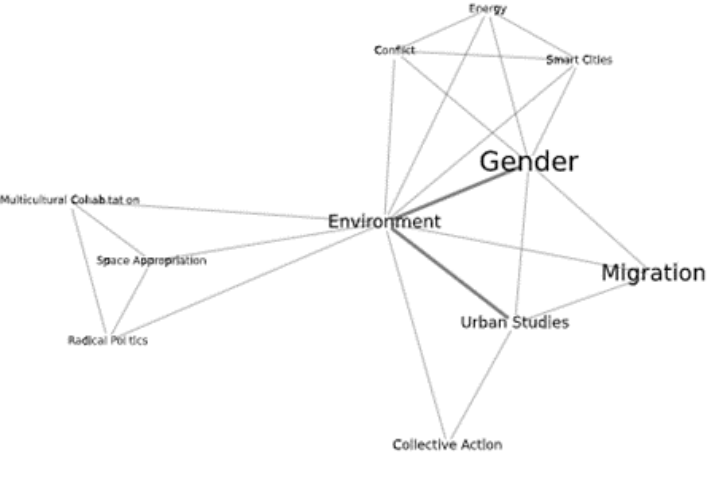
Figure 2. Example of co-occurrence network. Words that are considered as the most important are displayed in a bold and large font. Words are linked according to their co-occurrence in the texts. Visualising text networks creates challenges because dense networks are very